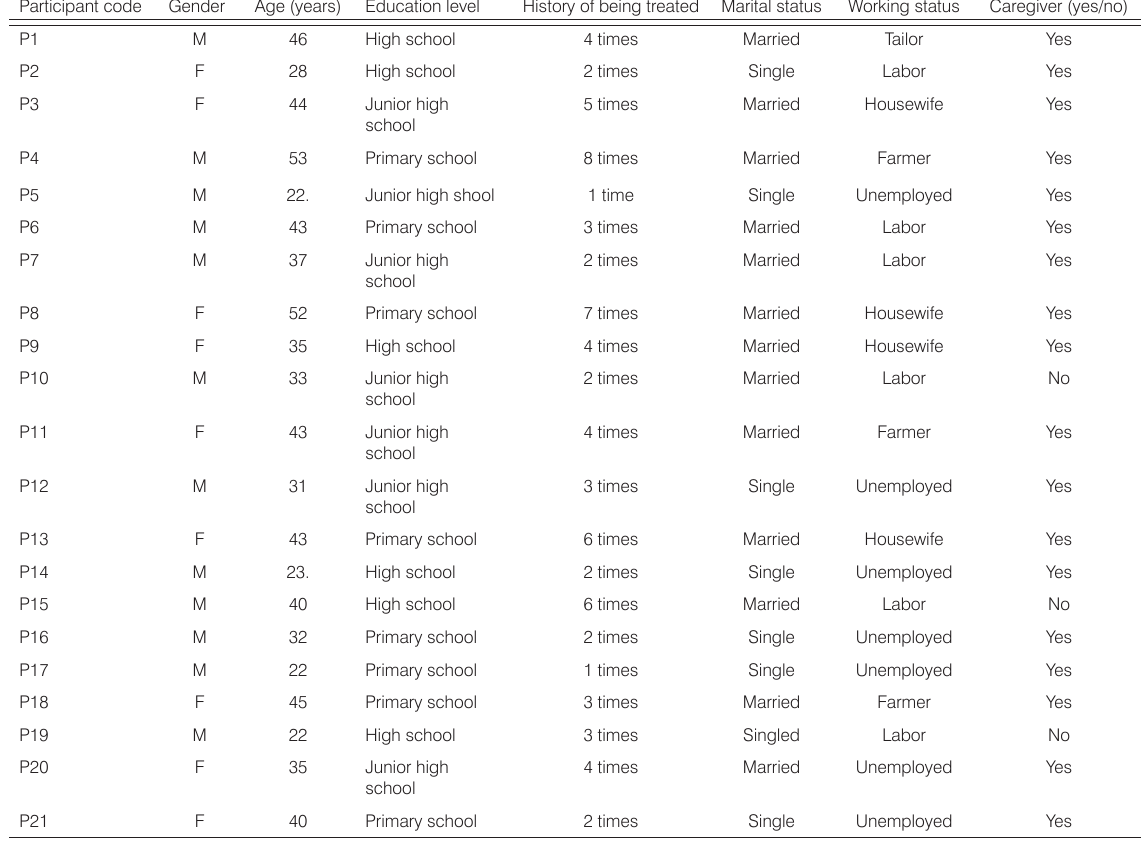
Table 1. Characteristics of the